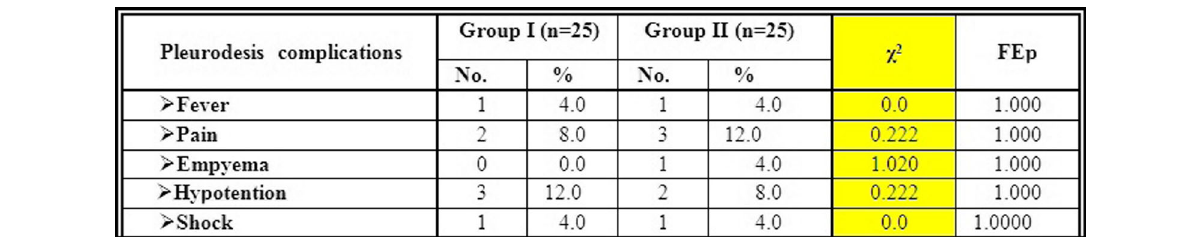
Table 8 Comparison between the groups as regard complications of